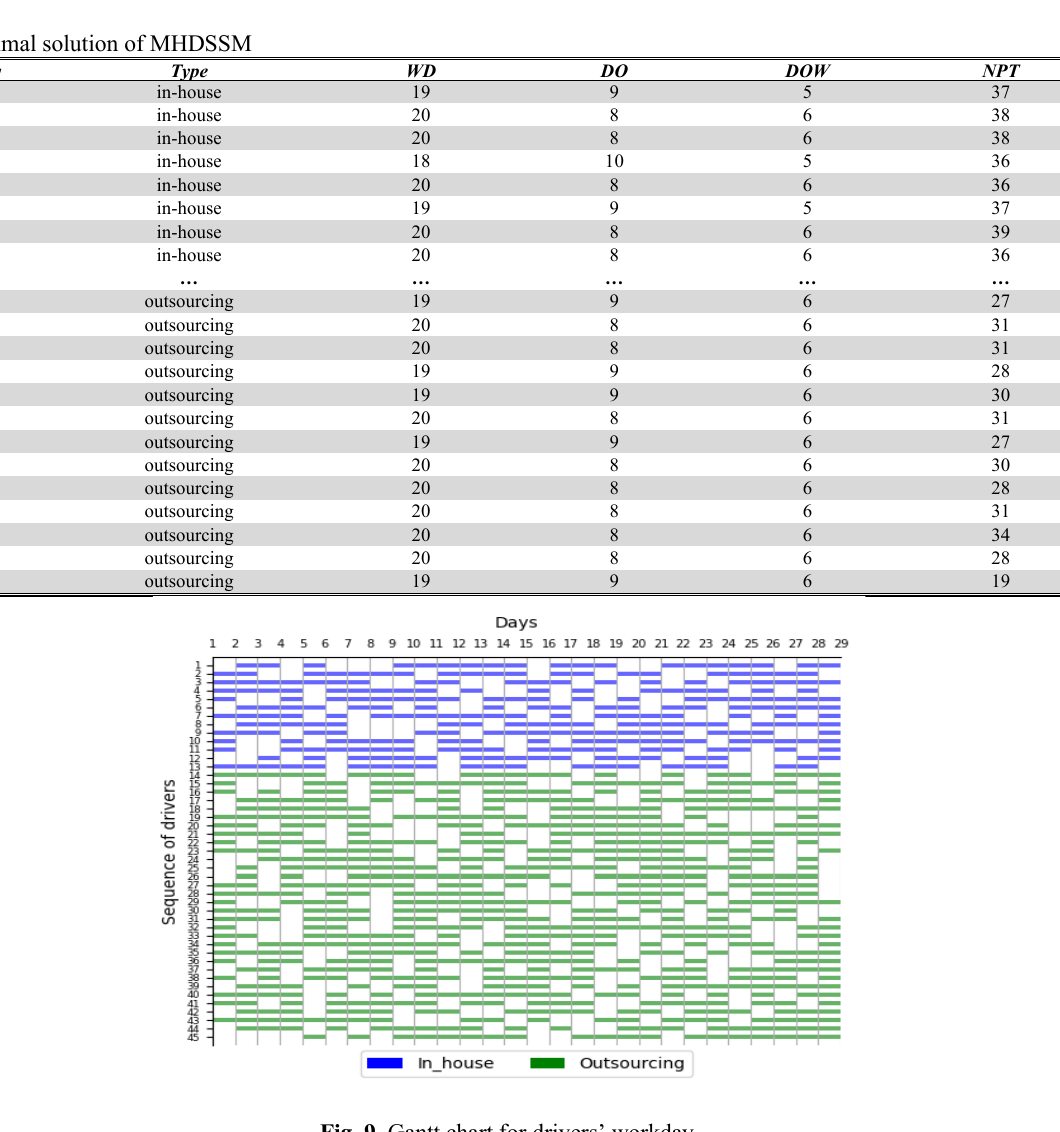
Fig. 9. Gantt chart for drivers’